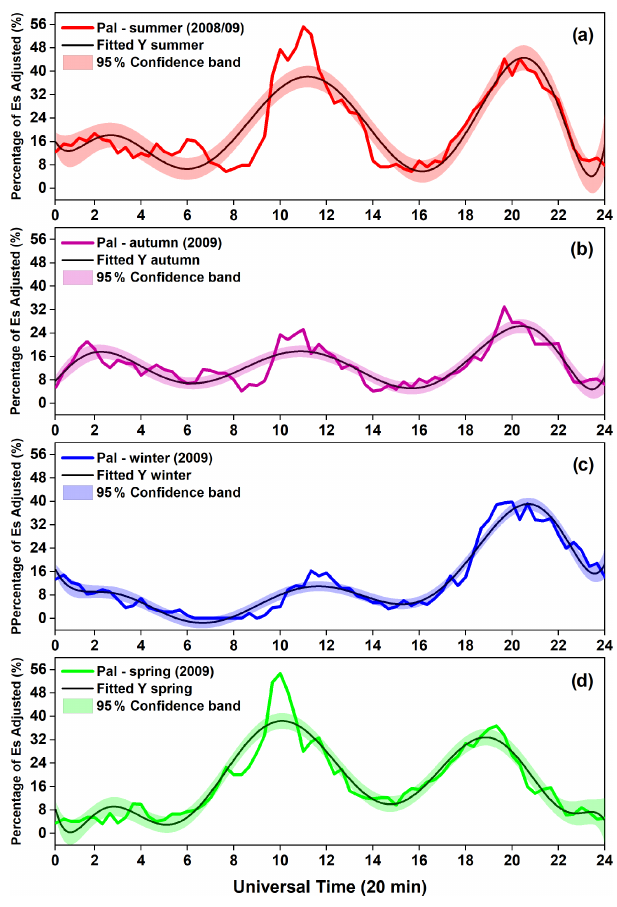
Figure 4. Temporal variation of E s layer occurrences obtained in in- tervals of 20min during summer (red line, a ), autumn (purple line, b ), winter (blue line, c ) and spring (green line, d ) seasons. The black lines in the panels are the fitted curves of the occurrence rates by applying a nonlinear regression. The shadowed bands in the fitted curves denote the 95% confidence interval of the best-fitted param-